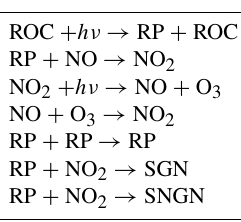
Table 1. Chemical reactions in the generic reaction set (GRS). ROC represents reactive organic compounds, RP represents radical pool, SGN represents stable gaseous nitrogen products and SNGN repre- sents stable non-gaseous nitrogen